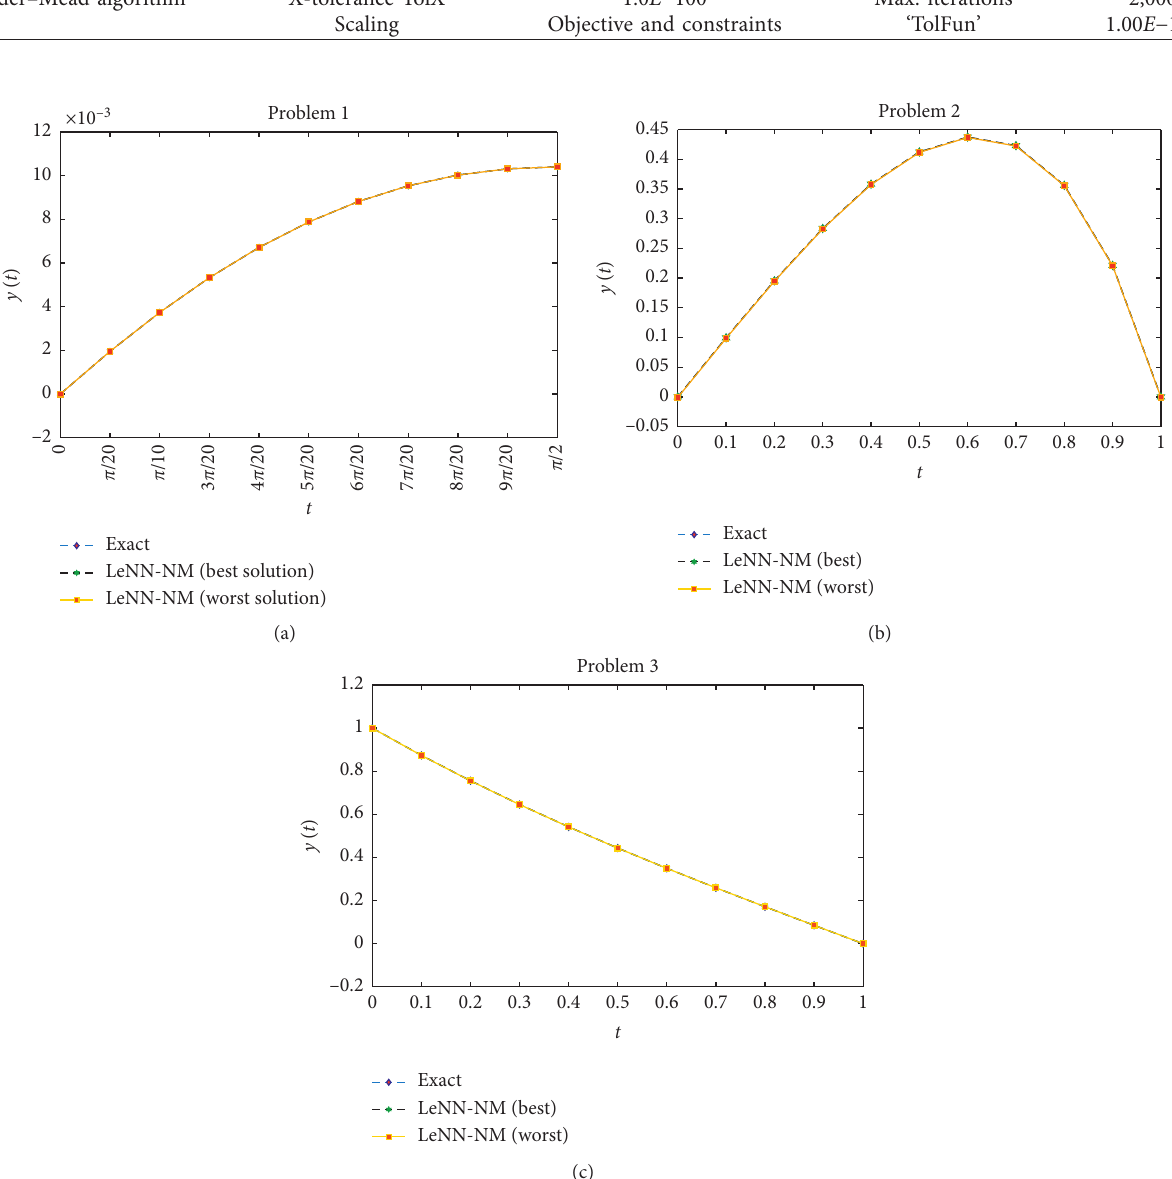
Figure 5: Best and worst approximate solution obtained by LeNN-NM algorithm along with exact solution for Problem 1, 2 and